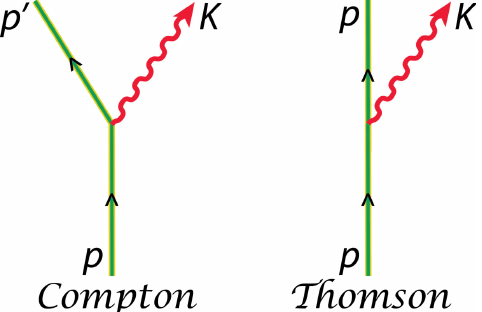
Figure 1. Feynman diagrams representing the Compton ( left ) and Thomson ( right ) scattering processes of electrons with initial four-momentum p . The final electron four-momentum is p (cid:48) and the emitted photon four-momentum is K . All particles are on their mass shells. The difference between these two processes is that for the classical Thomson scattering the electron final momentum is p (cid:48) = p , i.e., there is no electron